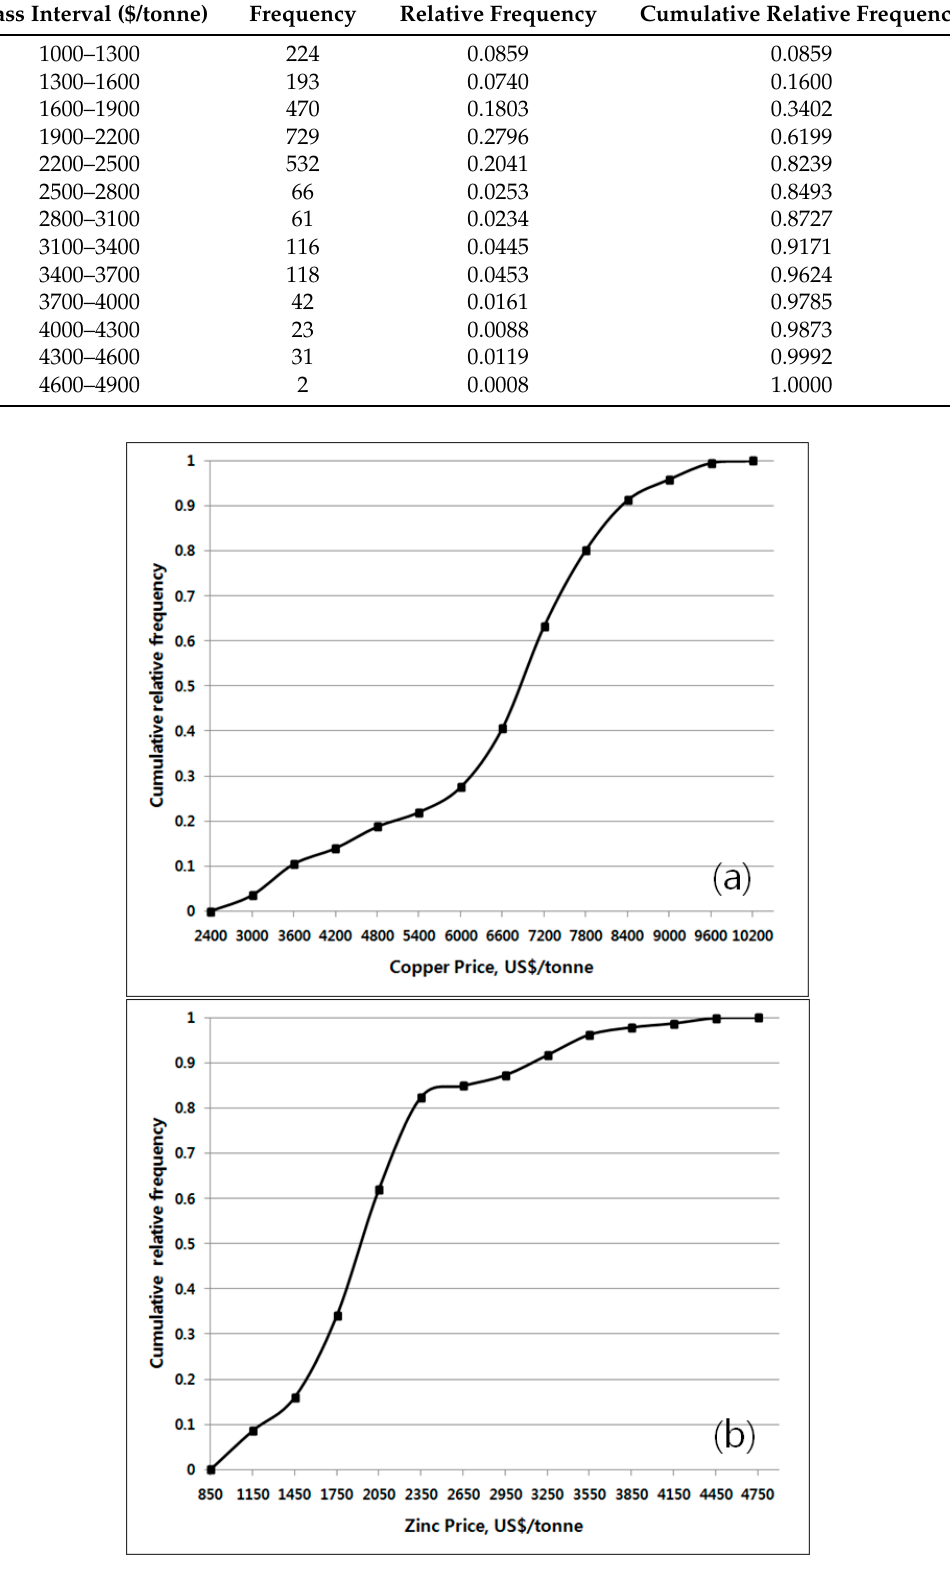
Figure 5. Cumulative relative frequency curves. ( a ) Copper prices; ( b ) Zinc prices.